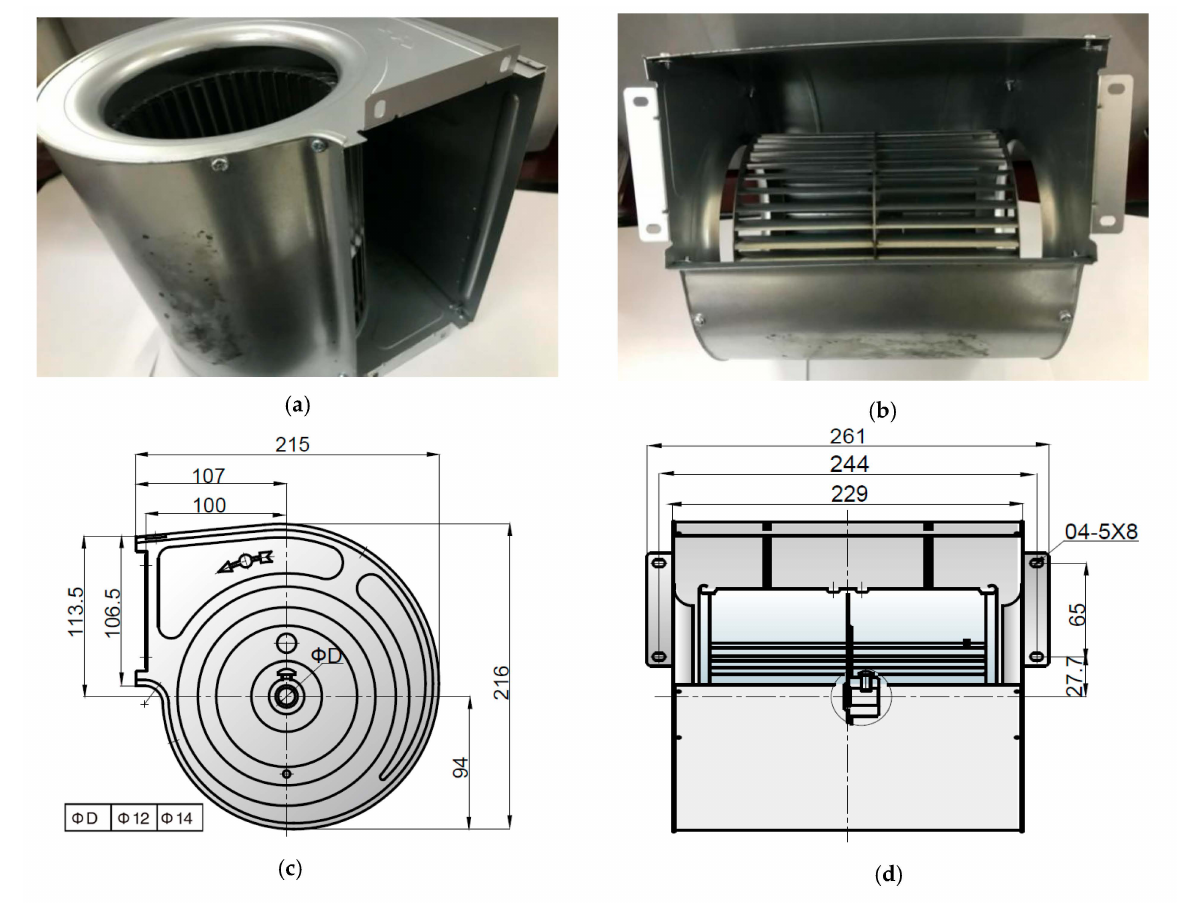
Figure 1. Fan drawing and structure. ( a ) Fan, ( b ) front view, ( c ) side view, ( d ) frontal view.